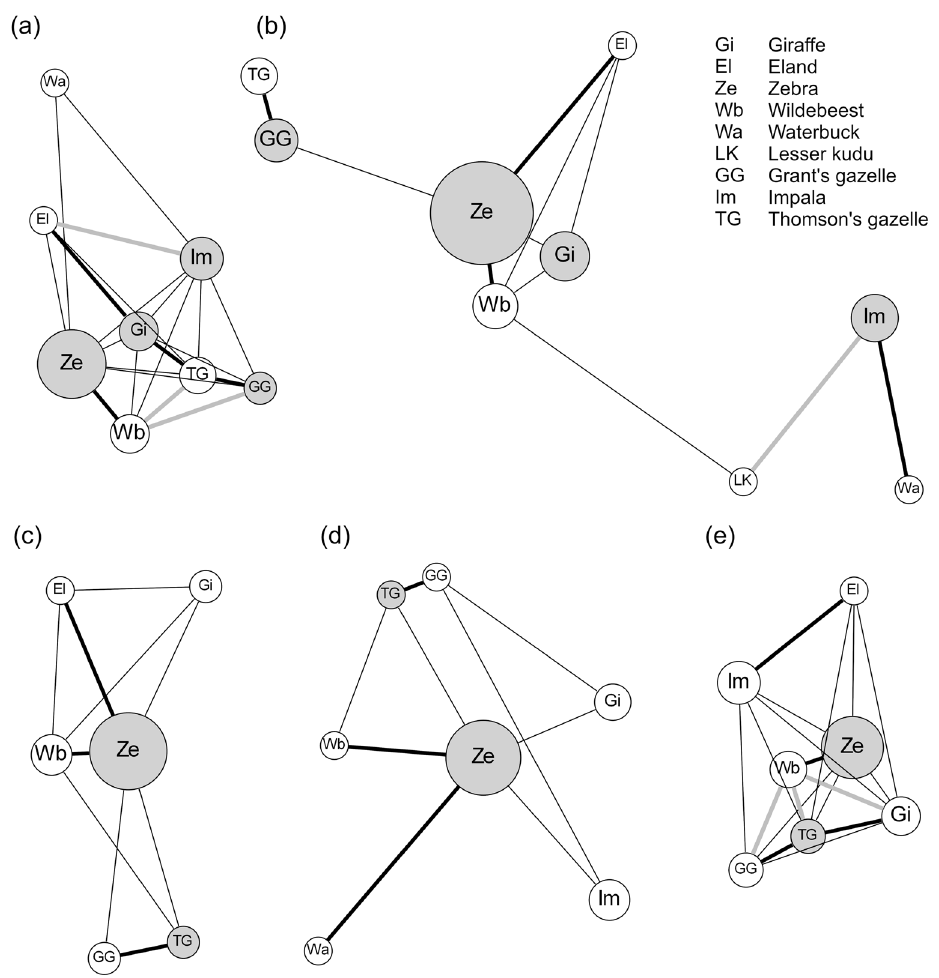
Figure 3. Social networks of focal species (grey circles) and non-focal species (white circles) based on animal groups observed ( a ) inside and ( b ) outside lion home range, and under ( c ) small, ( d ) medium and ( e ) large NDVI conditions. The thick black lines indicate associations that are significant, even if preferences for the same habitat types are taken into account, while for the thick grey lines the significance can be explained by such preferences. The node areas are proportional to the observed numbers of occurrences of the species. The layout follows a spring model, where the lengths of the edges correspond to the association strengths (Dice’s index). A short edge indicates a high value. For better readability, an edge is only shown, if its weight was ≥ 0.05 and if the two species co-occurred at least twice. Similarly, only the focal species and those species are shown that